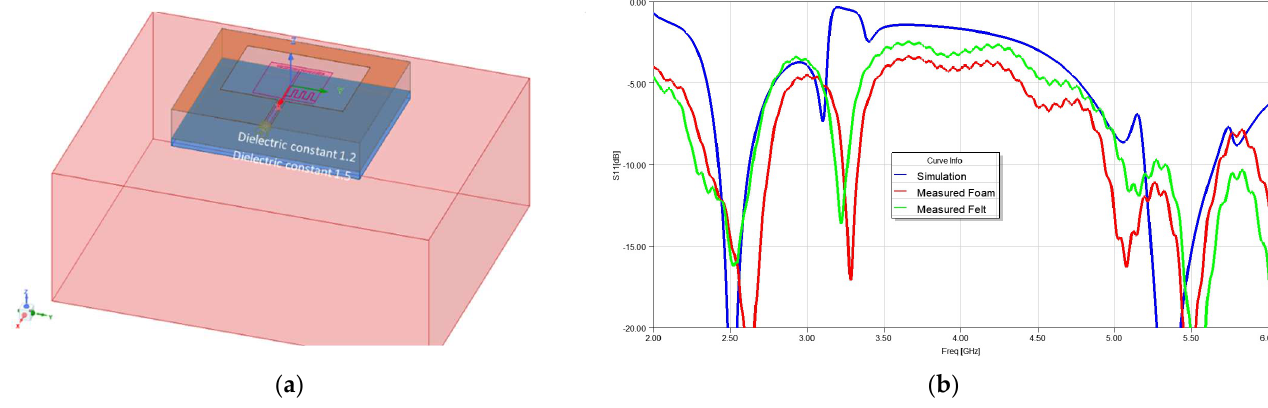
Figure 11. Antenna measurement on body considering the layer of cloth ( a ) assumption of the layers in the simulation; ( b ) measured S11 for the antenna on foam and felt substrates vs. simulation.